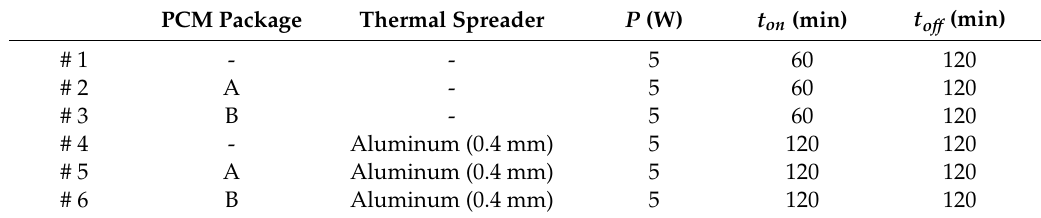
Table 4. List of the performed experiments with constant power